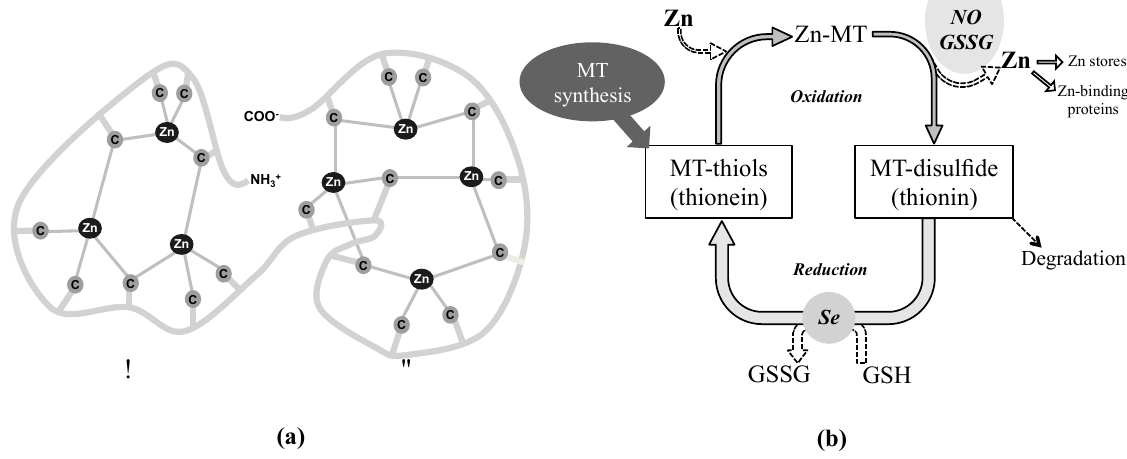
Figure 3. ( a ) Mammalian MTs contain 60–68 amino acids, 20 of which are cysteines that bind seven divalent metal ions in two metal/thiolate clusters, the α - and β -metal-binding domains. Eleven cysteines bind four zinc ions in the C-terminal α -cluster, whereas nine cysteines bind three zinc ions in the N-terminal β -cluster. ( b ) Zinc–metallothionein redox cycle: zinc bound to MT (Zn–MT) is released under physiological oxidative conditions, forming MT-disulfide (thionin), process boosted by free radicals derived from nitric oxide, ROS and oxidized glutathione. MT-disulfide may be degraded or reduced to MT-thiol (thionein) in the presence of a selenium-derived catalyst. MT-thiol binds zinc to form the thermodynamically stable Zn–MT system. Adapted from Gonzalez-Iglesias et al., 2014 [ Error! Bookmark not defined. ].